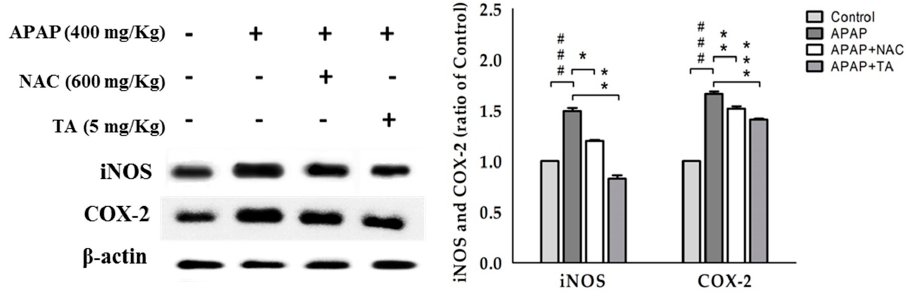
Figure 5. Tormentic acid inhibited iNOS and COX-2 expression in APAP-induced mice. β -actin served as a loading control. The values are reported as the means ± S.E.M. of five mice per group. ### p < 0.01 compared with the control group; * p < 0.05, ** p < 0.01, and *** p < 0.001 compared with the APAP